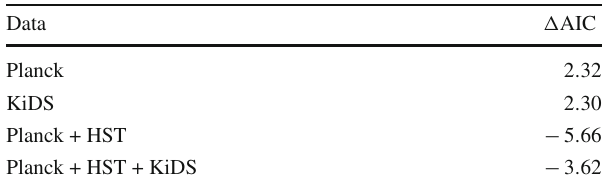
Table 3 Difference of AIC values of the IVCDM model with respect to reference model ( (cid:3) CDM) with all the data combinations used in